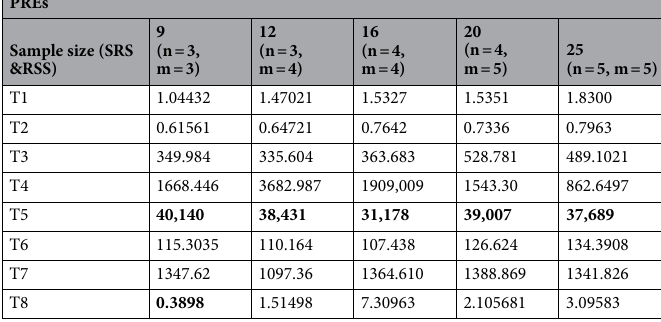
PREs Sample size (SRS